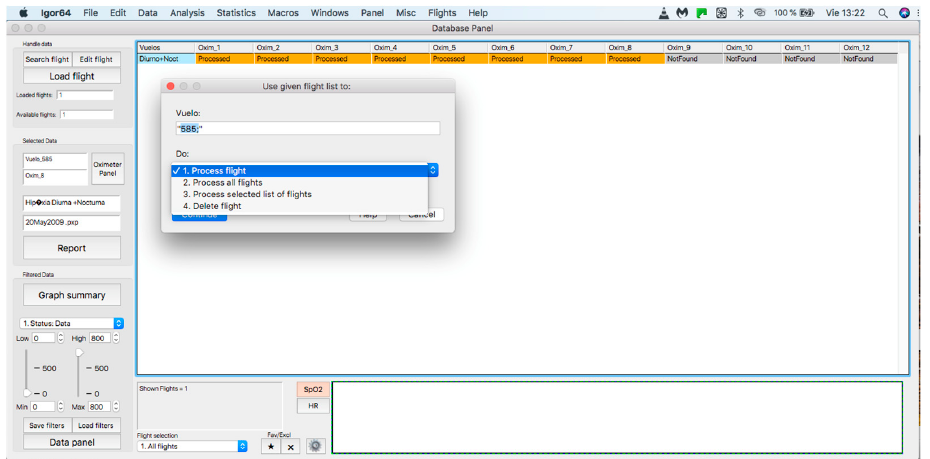
Figure 6. Editing a loaded and processed flight.